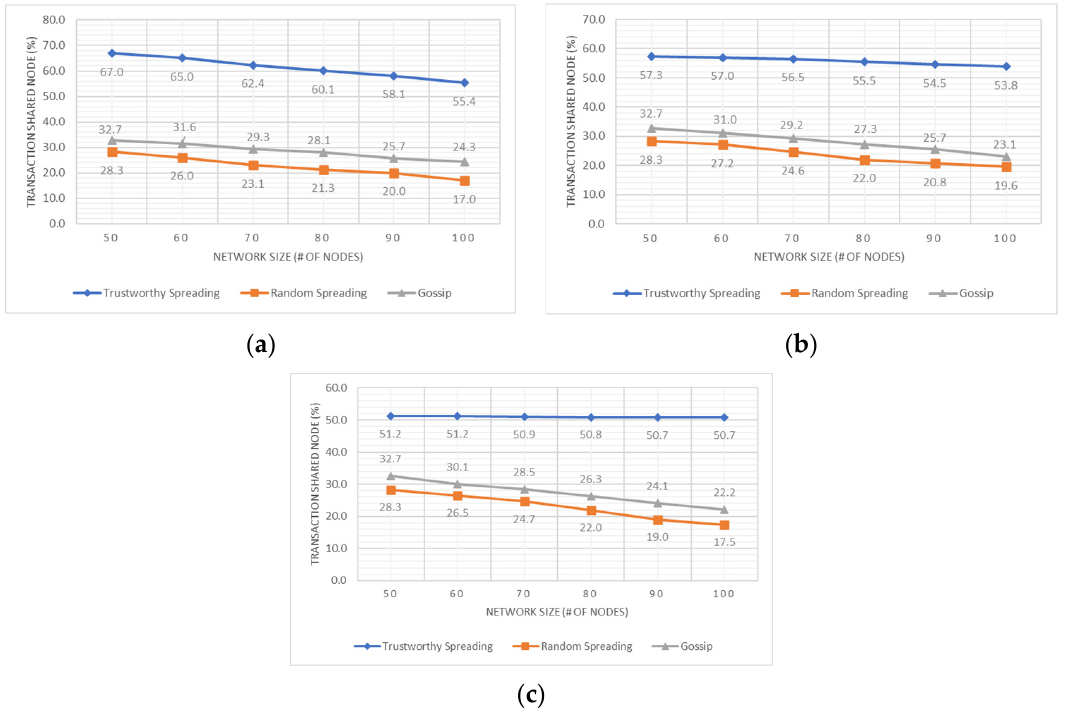
Figure 7. Transaction sharing rate. ( a ) Single malicious node; ( b ) Double malicious node; ( c ) Triple malicious nodes.